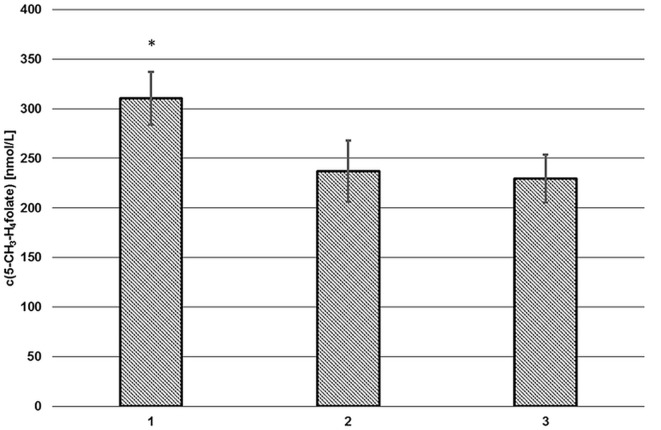
Extraction of volumetric absorptive microsamplers with (1) and without additional enzymes (2), without solid phase extraction/enzymes (3). Mean ± SD (n = 3). *Significant difference (p = 0.05).